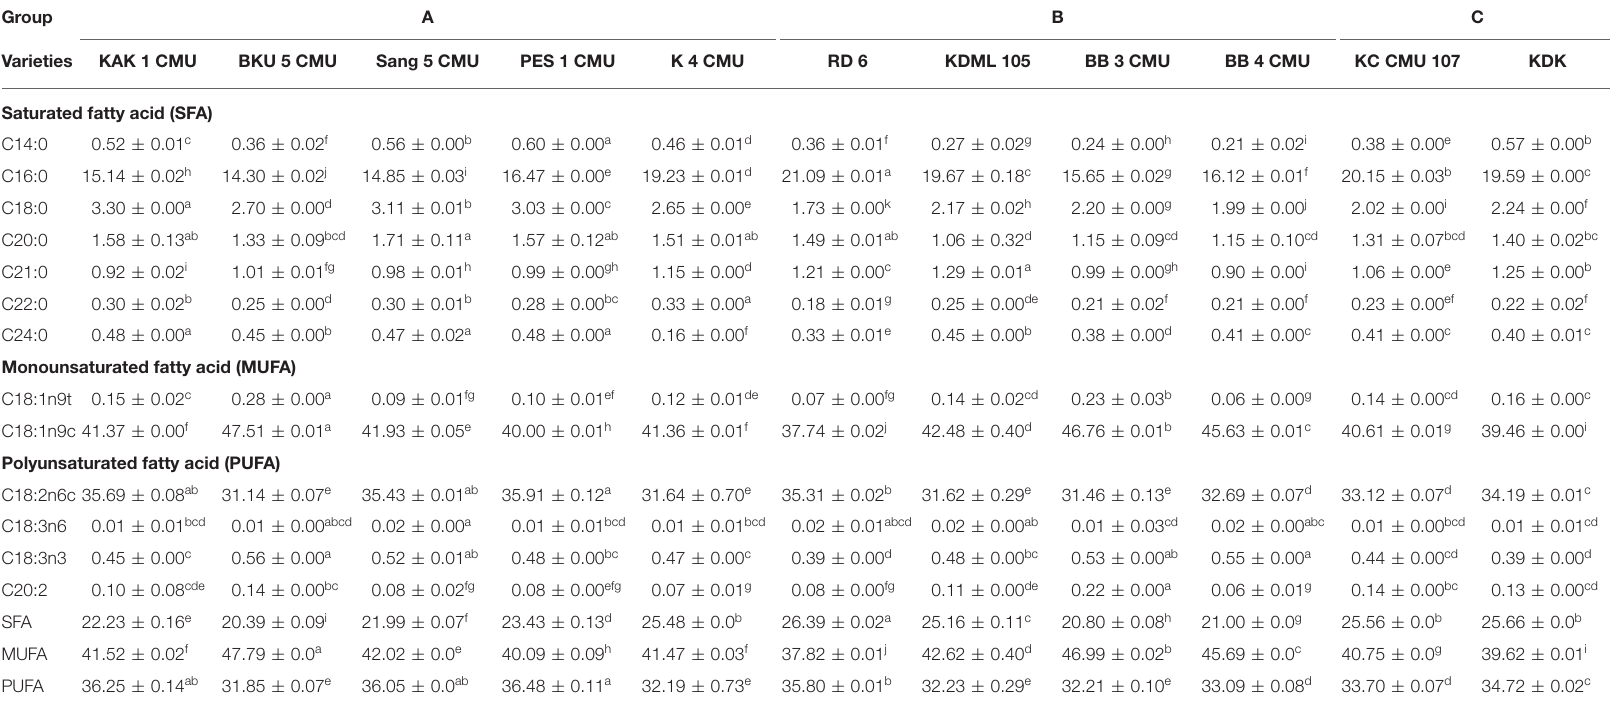
All values are mean ± SD; SFA, saturated fatty acids; MUFA, monounsaturated fatty acids; PUFA, polyunsaturated fatty acids. Values followed by different superscript letters in the same row are significantly different (P <